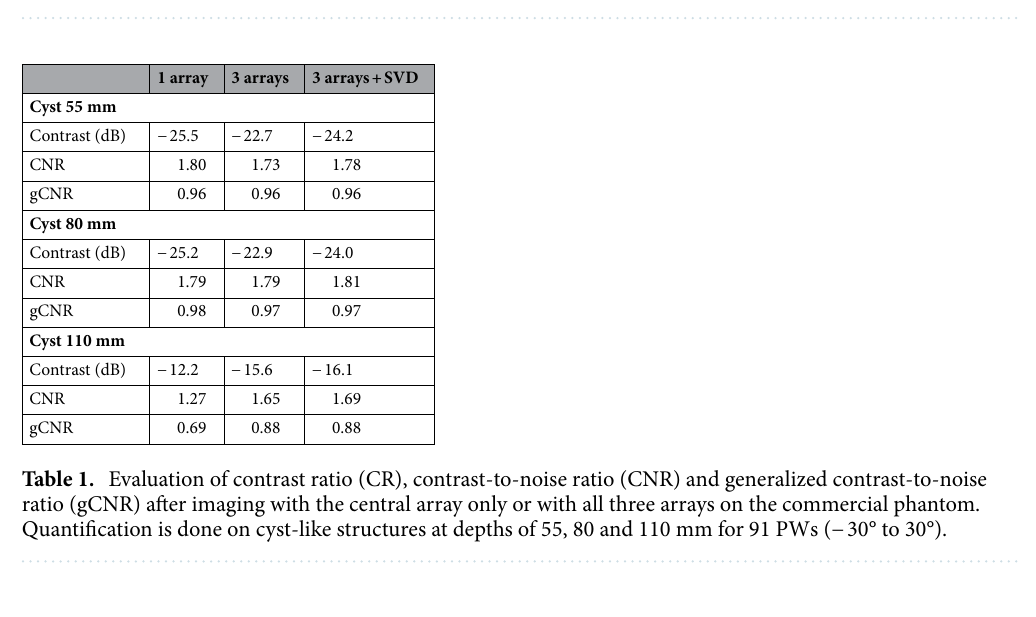
Figure 4. Quantification of contrast on the hypoechoic cyst located at 80 mm as a function of the number of plane waves. ( a – c ). Expanded view of the hypoechoic region located at 80 mm (green rectangle in Fig. 3 ( b ) and ( d )) going from one array ( a ) to three arrays ( b ) and after applying the SVD beamformer ( c ). The ROIs indicate the inside and outside areas selected to calculate the contrast metrics. The dynamic range is 60 dB for all images. ( d ) The autocorrelation of the speckle as a function of the lateral distance confirms the change in speckle aspect utilizing three arrays with reduced lateral correlation distance. ( e ) The contrast ratio as a function of the number of angles shows a slight degradation going from one to three arrays that is partially compensated by the SVD beamformer. ( f , g ) The contrast-to-noise ratio ( f ) and generalized contrast-to-noise ratio ( g ) as a function of the number of angles are very similar between one and three arrays, especially for a higher number of angles. A small degradation is seen for three arrays for a small number of angles but is compensated when applying the SVD beamformer.